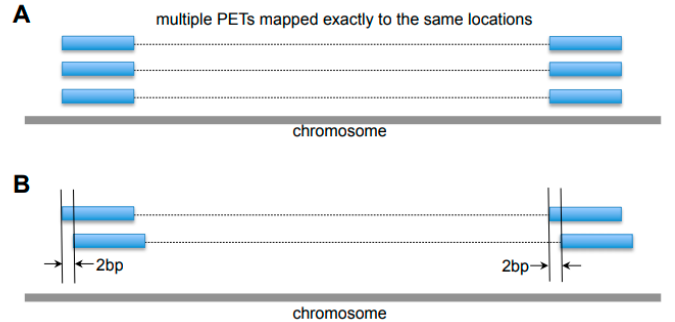
Figure 5. Examples of noises in the ChIA-PET data. ( A ) Duplicates of Paired-End Tags (PETs) from Polymerase Chain Reaction (PCR) amplification, which are mapped exactly to the same locations. ( B ) Different PETs with tags within 2 bp at both ends.